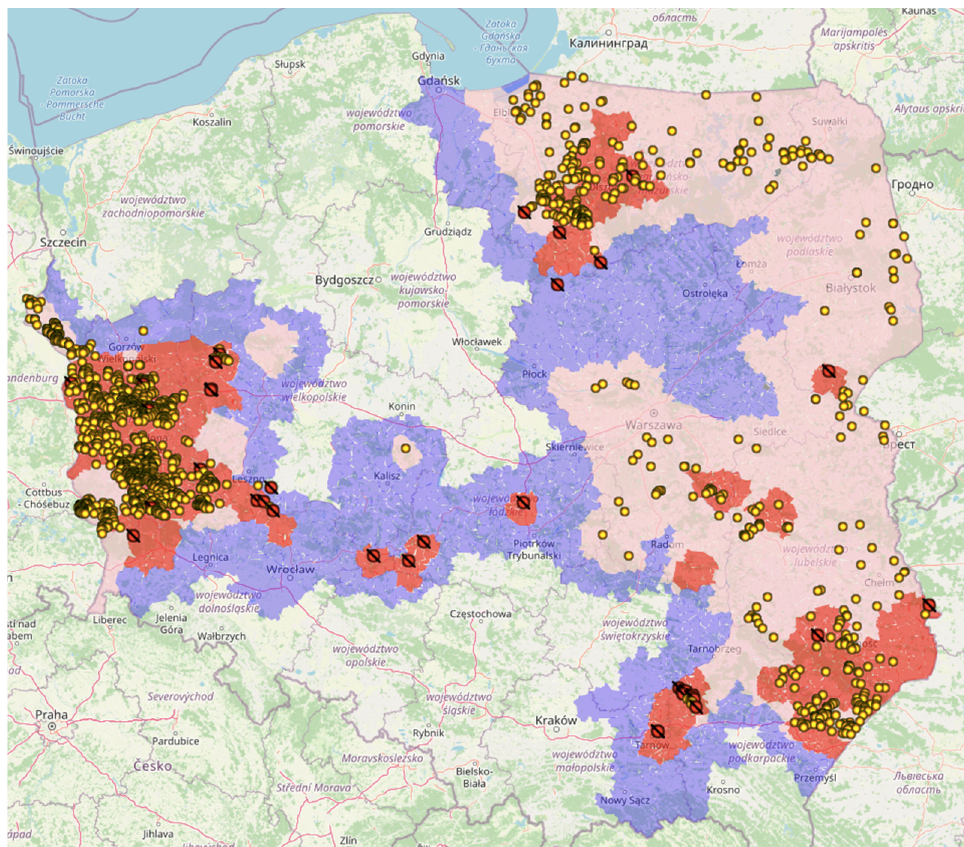
Figure 2. Current epidemiological situation regarding the emergence of ASF in Poland. The ASF- affected areas, in particular voivodeships, are indicated. The yellow points indicate wild boar ASF outbreaks in 2021, while red-crossed circles outline ASF outbreaks in domestic pigs. Source: General Veterinary Inspectorate: https://bip.wetgiw.gov.pl/asf/mapa/ (accessed on 30 July 2021). The colors of ASF-restricted zones I, II and III are consistent with the European Commission Regulation (EU) 2021/605 implemented on 7 April 2021.